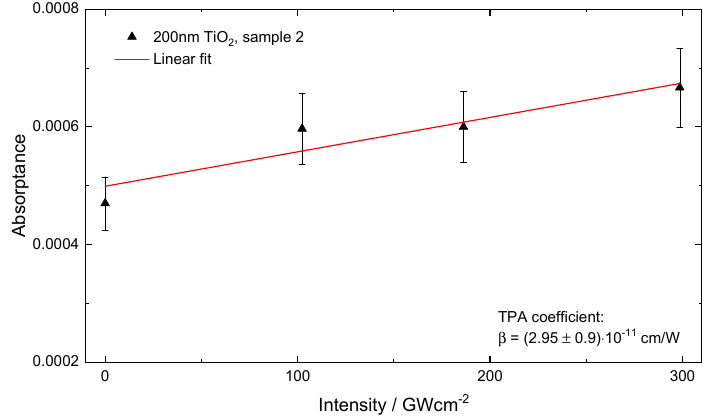
Coatings 2020 , 10 , x FOR PEER REVIEW Figure 7. Absorptance versus laser intensity and the TPA coe ffi cient for sample 2. Figure 7. Absorptance versus laser intensity and the TPA coefficient for sample 2. Figure 7. Absorptance versus laser intensity and the TPA coefficient for sample 2.